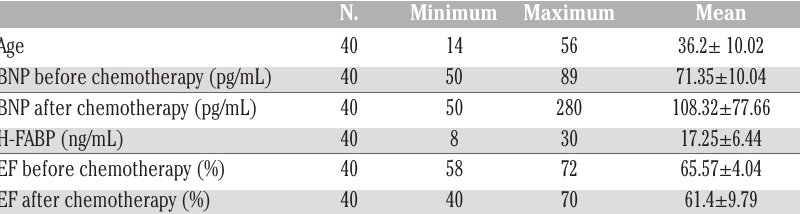
Table 1. Biochemical markers and ECHO findings in our patients.